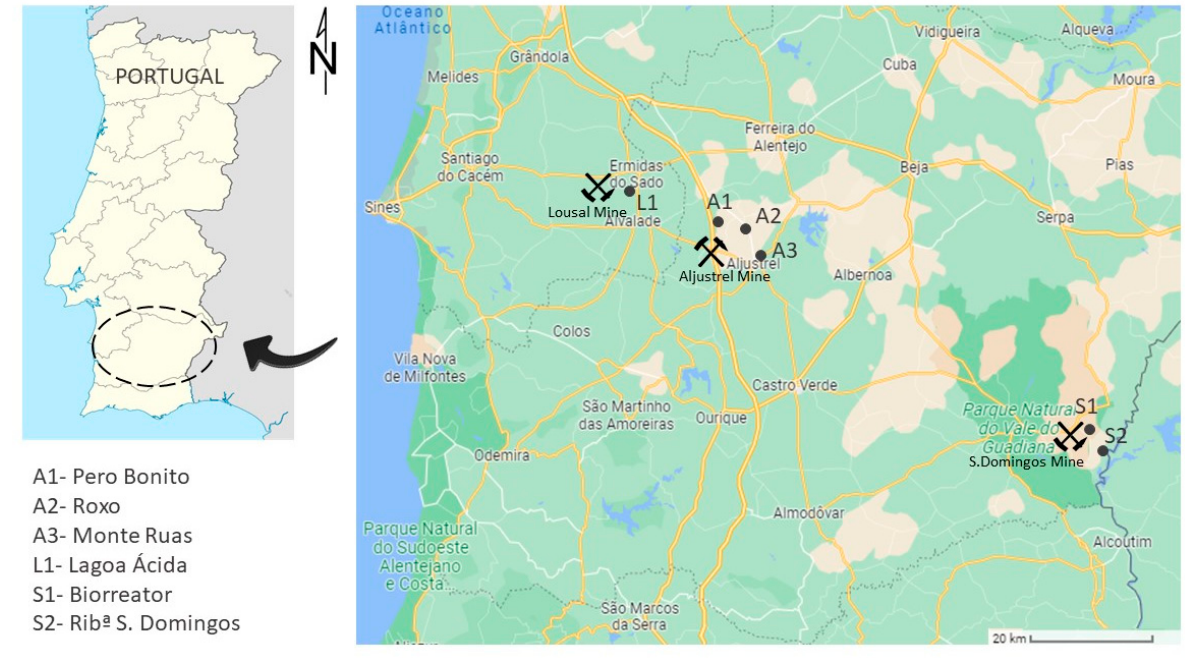
Figure 1. Location of Lousal, Aljustrel and S. Domingos mines, and, respective, sampling points L1—Lagoa Ácida, A1—Pero Bonito, A2—Roxo, A3—Monte Ruas, S1—Biorreator and S2—Ribª S. Domingos; names of sites are given to facilitate comparison with the same sites of author’s previous papers [15–17,26].